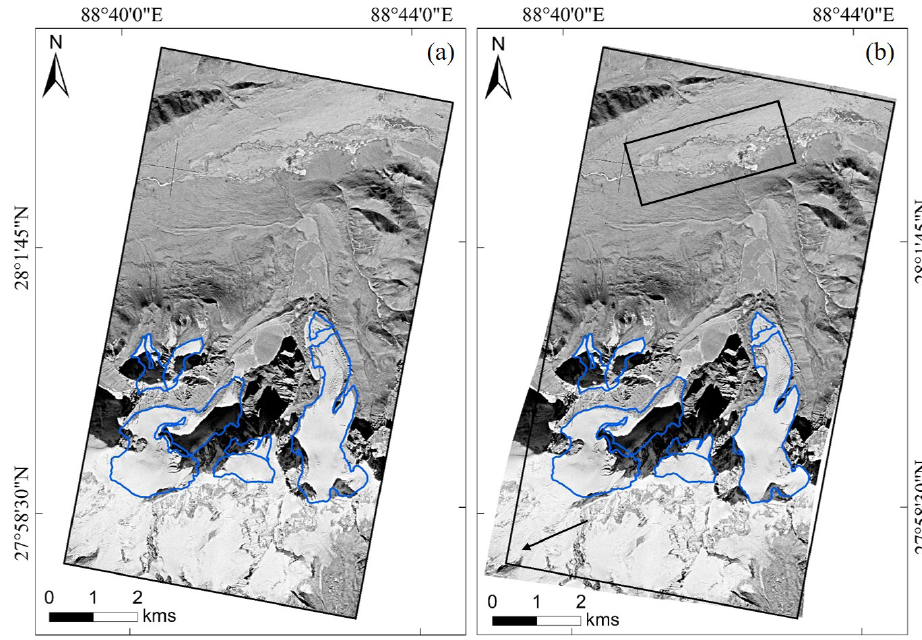
Figure 4. Methods adopted for glacier mapping: (a) subset KH-9 image near the Gurudongmar region before perfect geometric rectification using spline transformation method (STM); (b) distortion fields of the same KH-9 image along the mountain ridges after geometric recti- fication. Note the difference in distortion was more clearly noticed near the flat areas of braided glacial streams (rectangle) in the north of Gurudongmar Tso than at the Kangchengyao Massif (arrow) in the